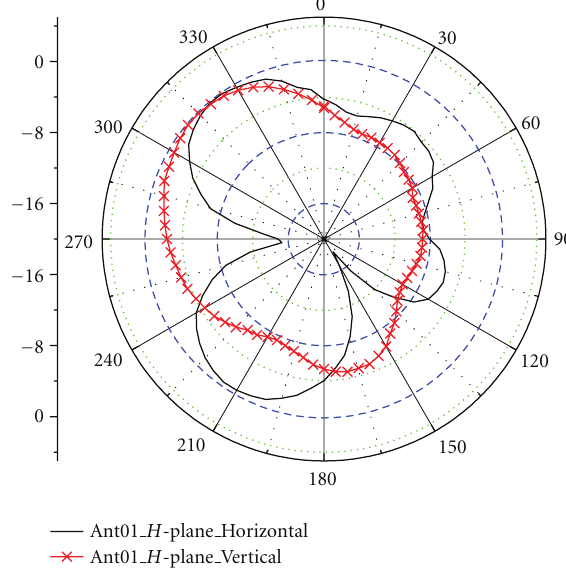
Figure 5: Measured S 11 and S 21 Curves.